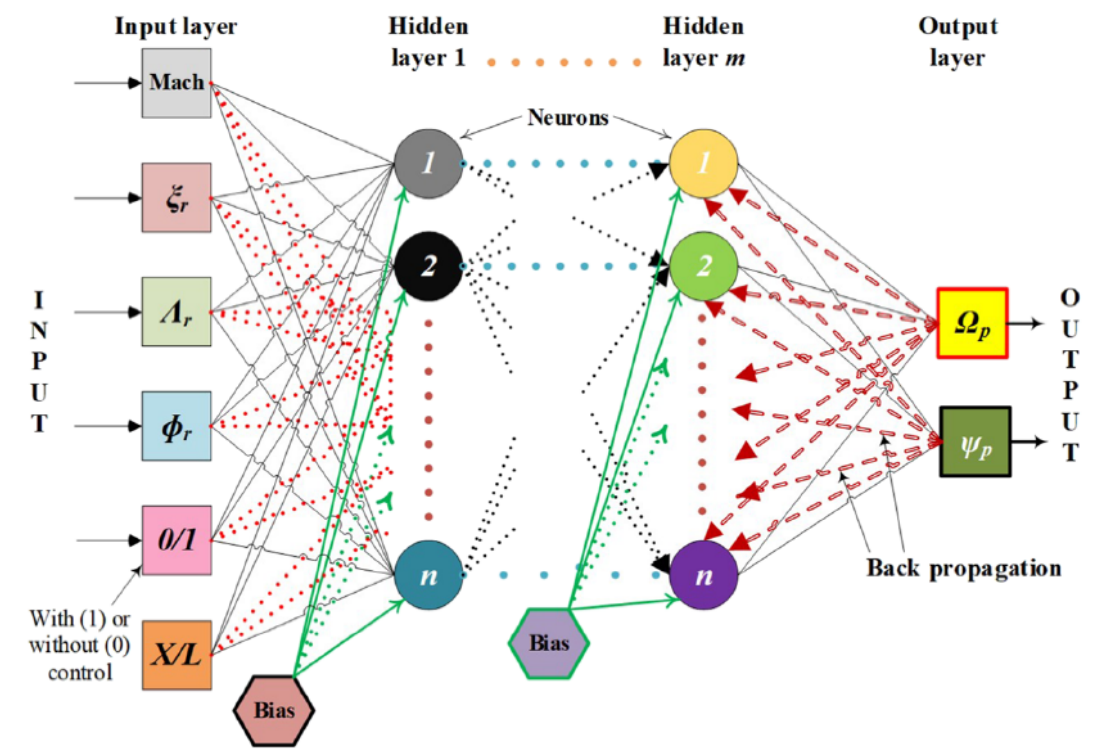
Figure 12. Back-propagation for base pressure modeling. Reprinted with permission from ref. [167]. Copyright 2020